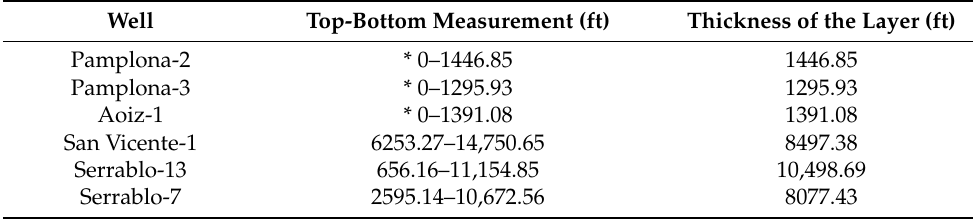
Table 1. Productive layer thickness in each of the wells (Hgross). Well Top-Bottom Measurement (ft)